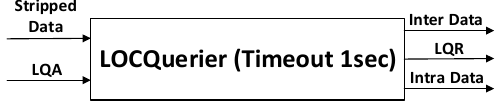
Figure 18. LOCQuerier() element’s architecture.